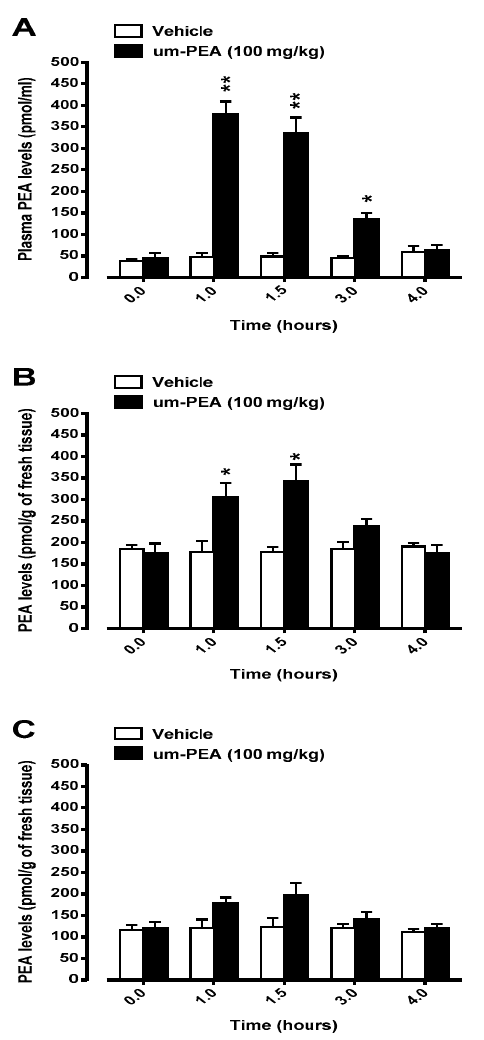
Figure 1. Levels of palmitoylethanolamide (PEA) in plasma ( panel A ), hippocampus ( panel B ) and prefrontal cortex ( panel C ) of non-Tg mice 1, 1.5, 3, and 4 hours after oral administration (by gavage ) of 100 mg/kg ultramicronized palmitoylethanolamide (um-PEA) or its vehicle [water/PEG/Tween-80 (90/5/5 ratio), v/v )]. Data are means ± SEM of five animals for each group. * p < 0.05; ** p < 0.01 significantly different from the respective vehicle time-point (Student t -test).